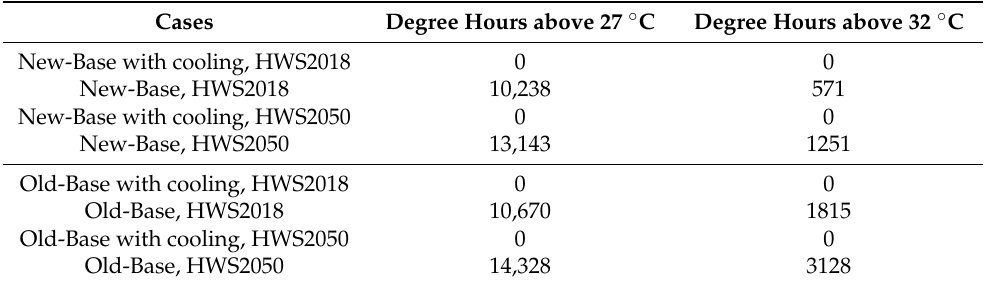
Table 10. The April to September degree hours above 27 ◦ C and 32 ◦ C, under HWS2018